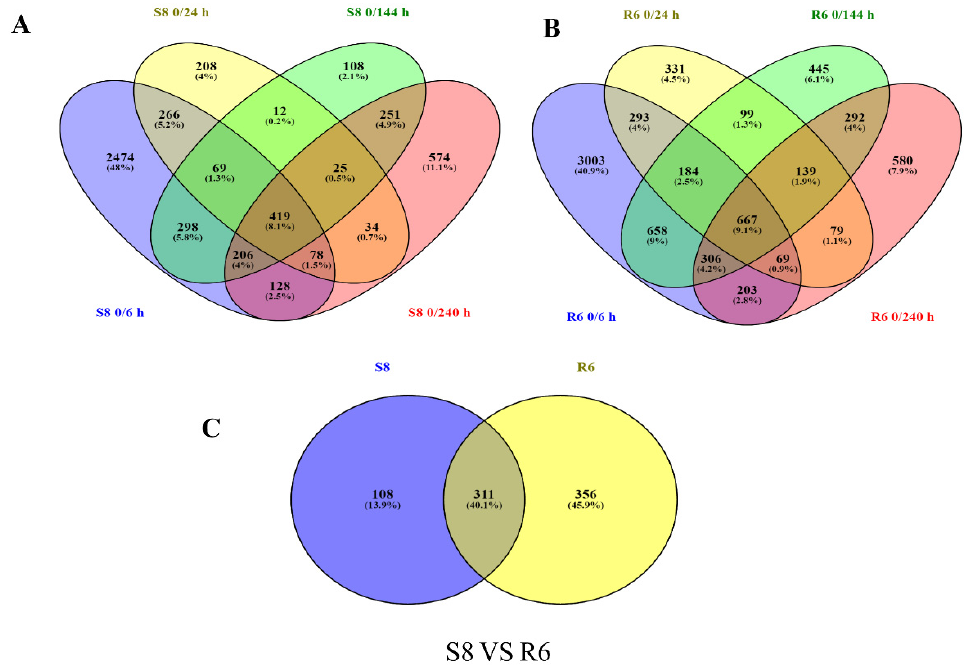
Figure 3. Differentially expressed genes in R6 and S8 at various times after inoculation with C. zeina . ( A ) Venn diagrams of DEGs in the GLS-sensitive line S8; ( B ) Venn diagrams of DEGs in resistant line R6. ( C ) Venn diagrams of common DEGs to R6 and S8.